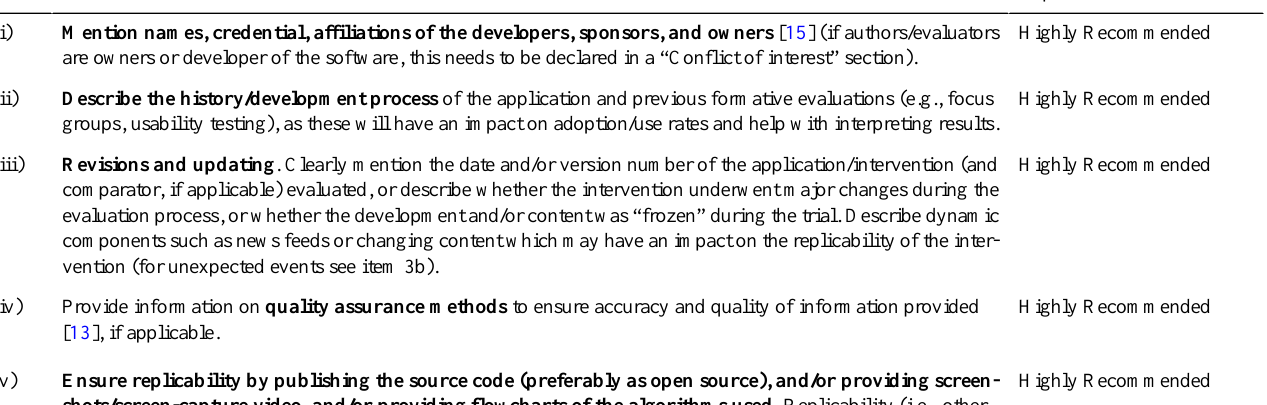
Table 2. Subitems expanding CONSORT item 5 (description of intervention)